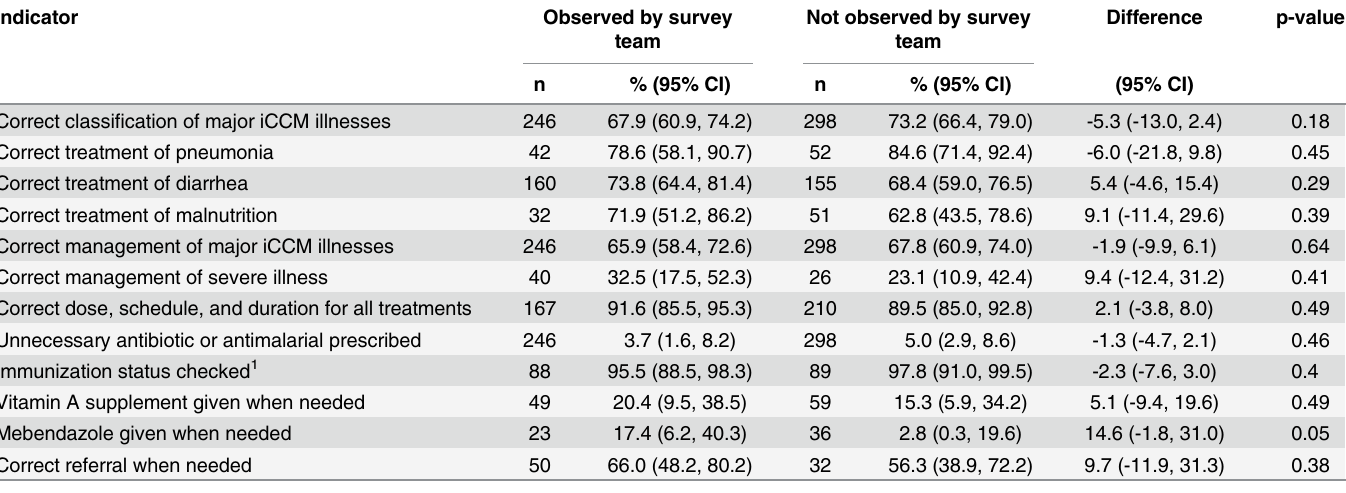
Table 3. Differences in estimates of indicators of quality of care from register review for children observed by the survey team and children not observed.